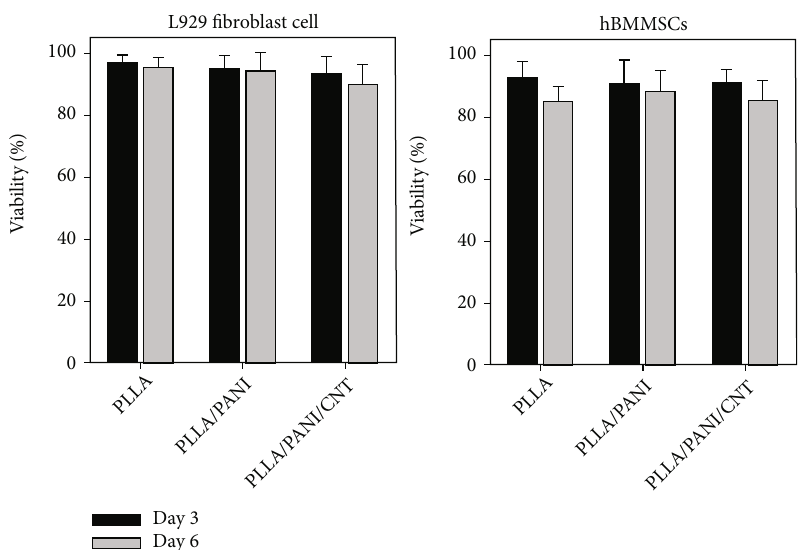
Figure 6: The viability of fi broblasts and human bone-marrow mesenchymal stem cells (hBMMSCs) on PLLA, PLLA/PANI, and PLLA/ PANI/CNT nano fi brous sca ff olds after being cultured for 3 and 6 days. The presented data are expressed as mean ± SD ( n = 3